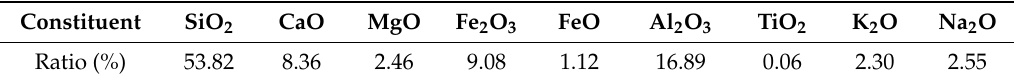
Table 1. The constituents of the selected float stone.